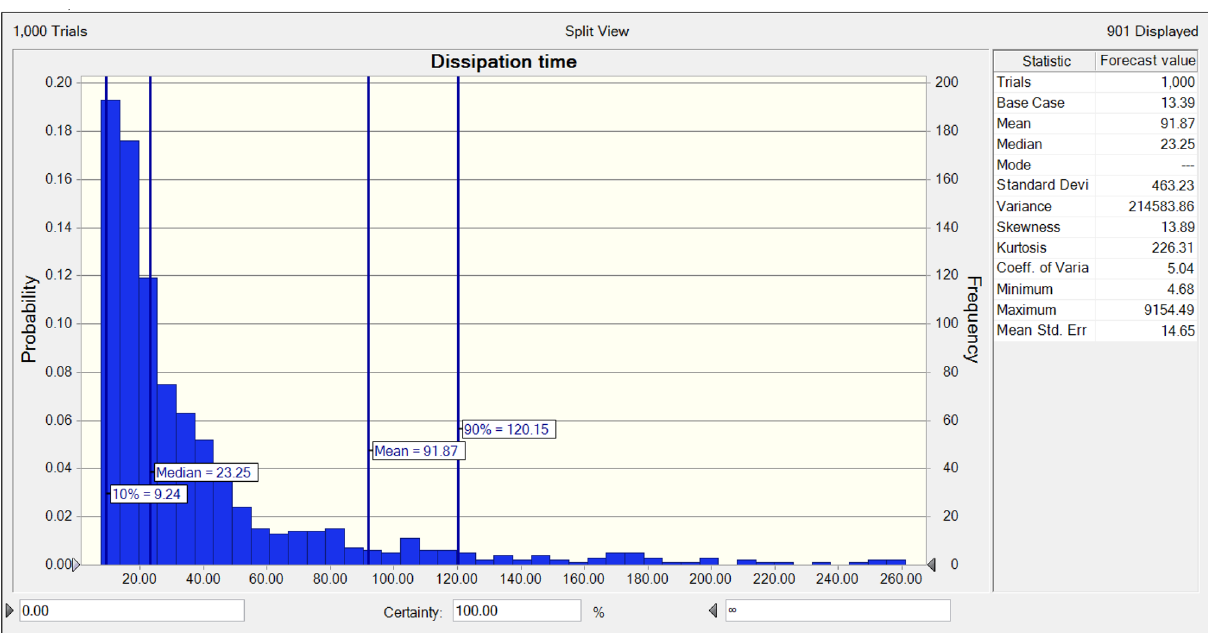
Fig. 8 Simulation results of dissipation time